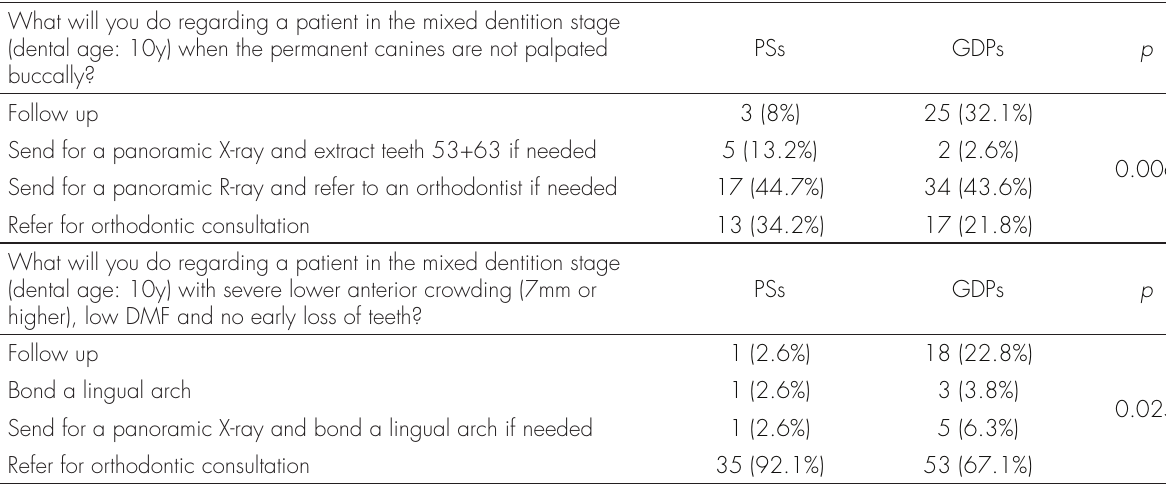
Table IV. Responses for the multiple choice questions regarding orthodontic cases